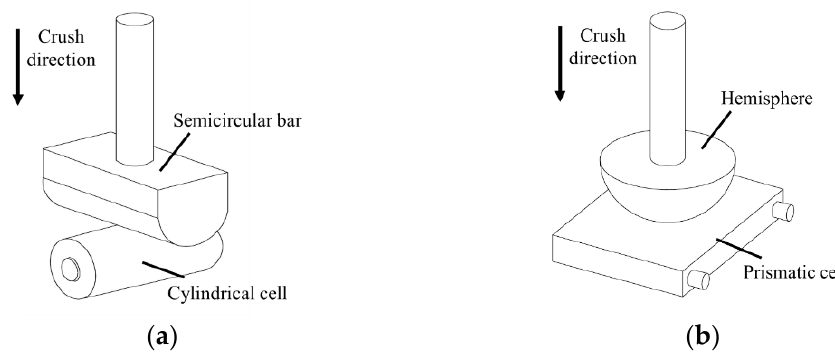
Figure 1. Schematic diagram of the crush test: ( a ) cylindrical cell; ( b ) prismatic cell.